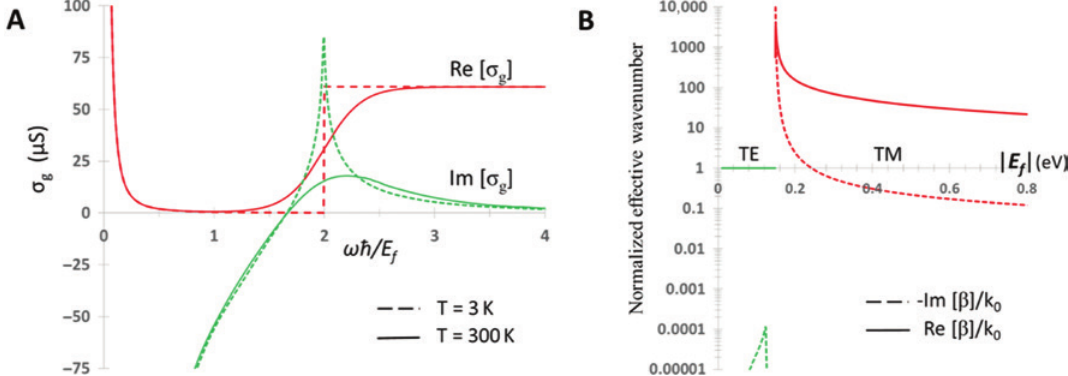
Figure 2: Surface conductivity of graphene and associated surface waves. (A) Surface conductivity of graphene as a function of frequency (normalized by chemical potential) at different temperatures (T), and (B) surface wave propagation constant (normalized by free-space wavenumber) as a function of chemical potential at ω ( ω /2 π = 60